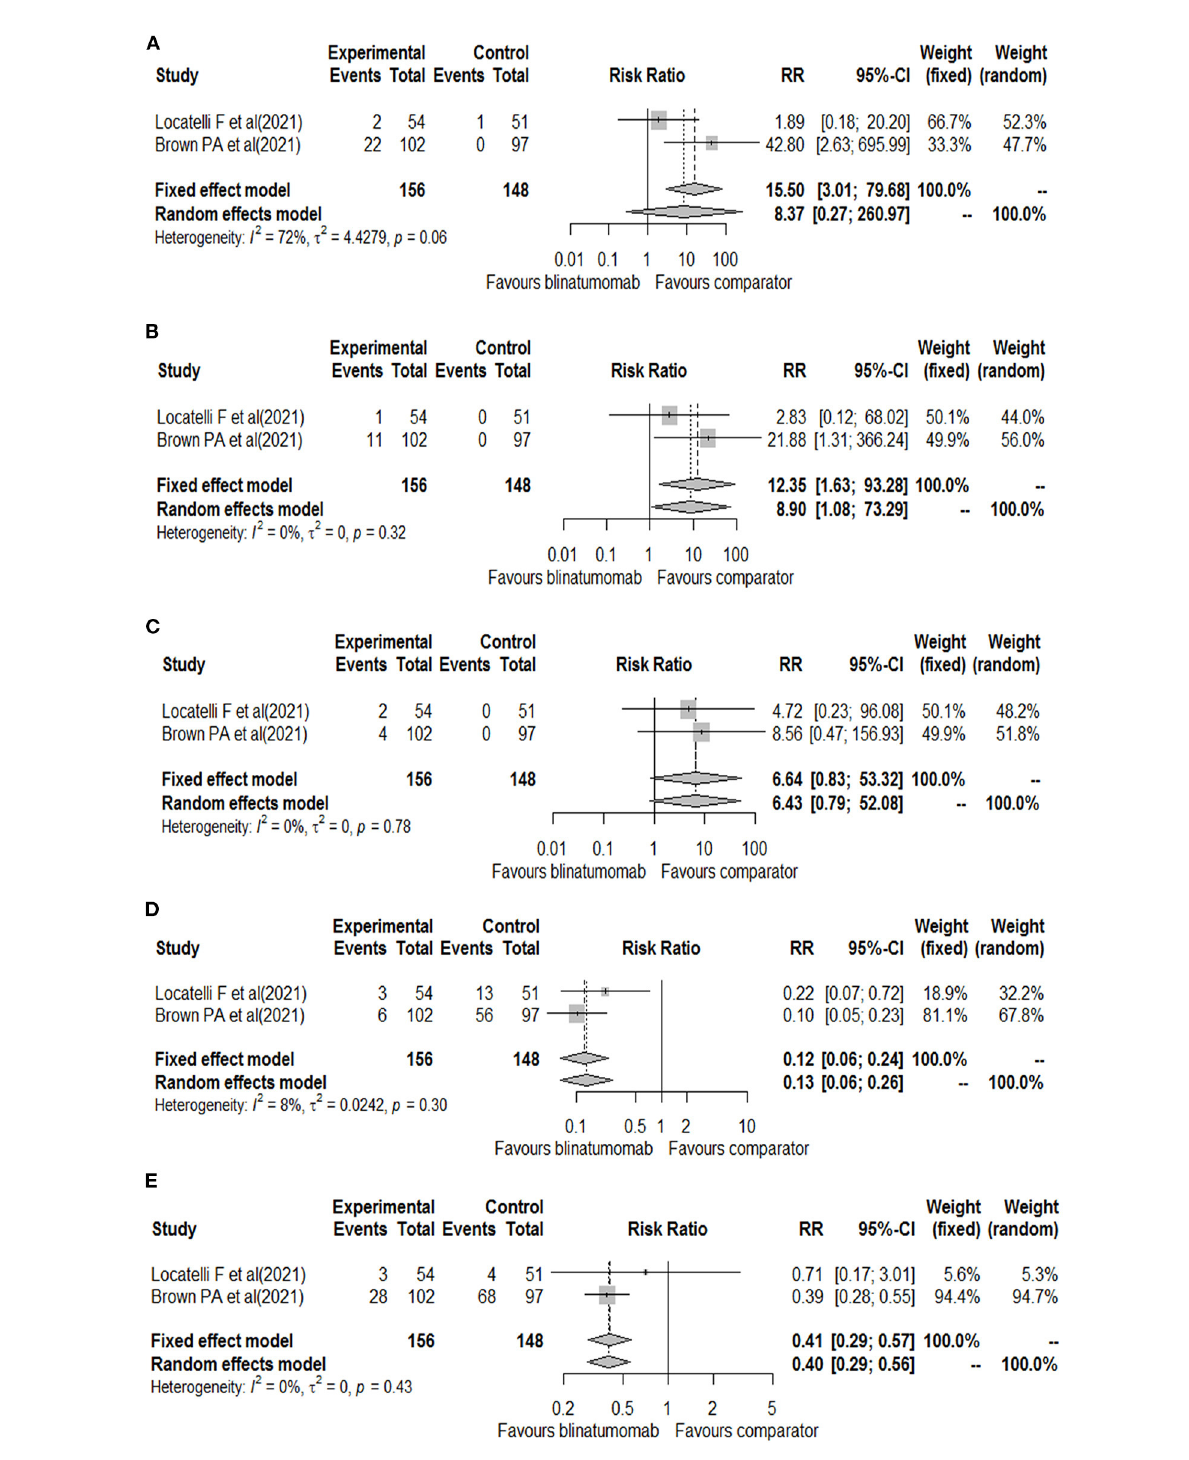
FIGURE3 Forest plot of cytokine release syndrome (A) , encephalopathy (B) , seizure (C) , febrile neutropenia (D) , and infections (E) with blinatumomab vs.